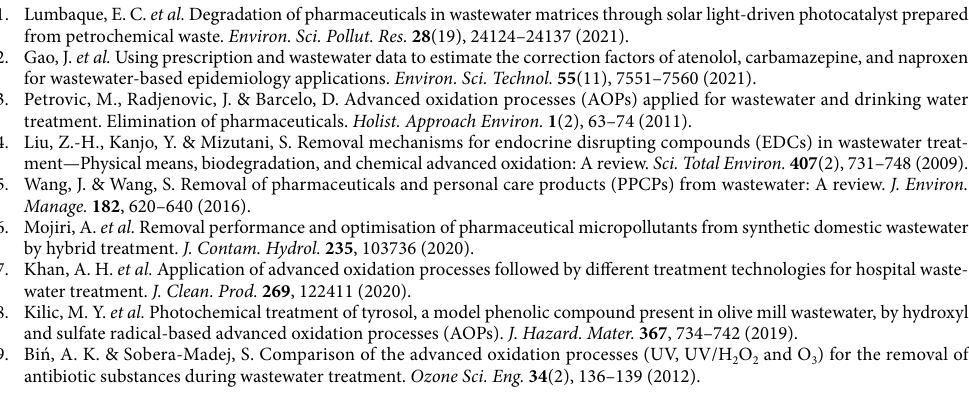
Table 7. Comparison of naproxen removal efficiency in the presence of synthesized photocatalyst under optimum process conditions.